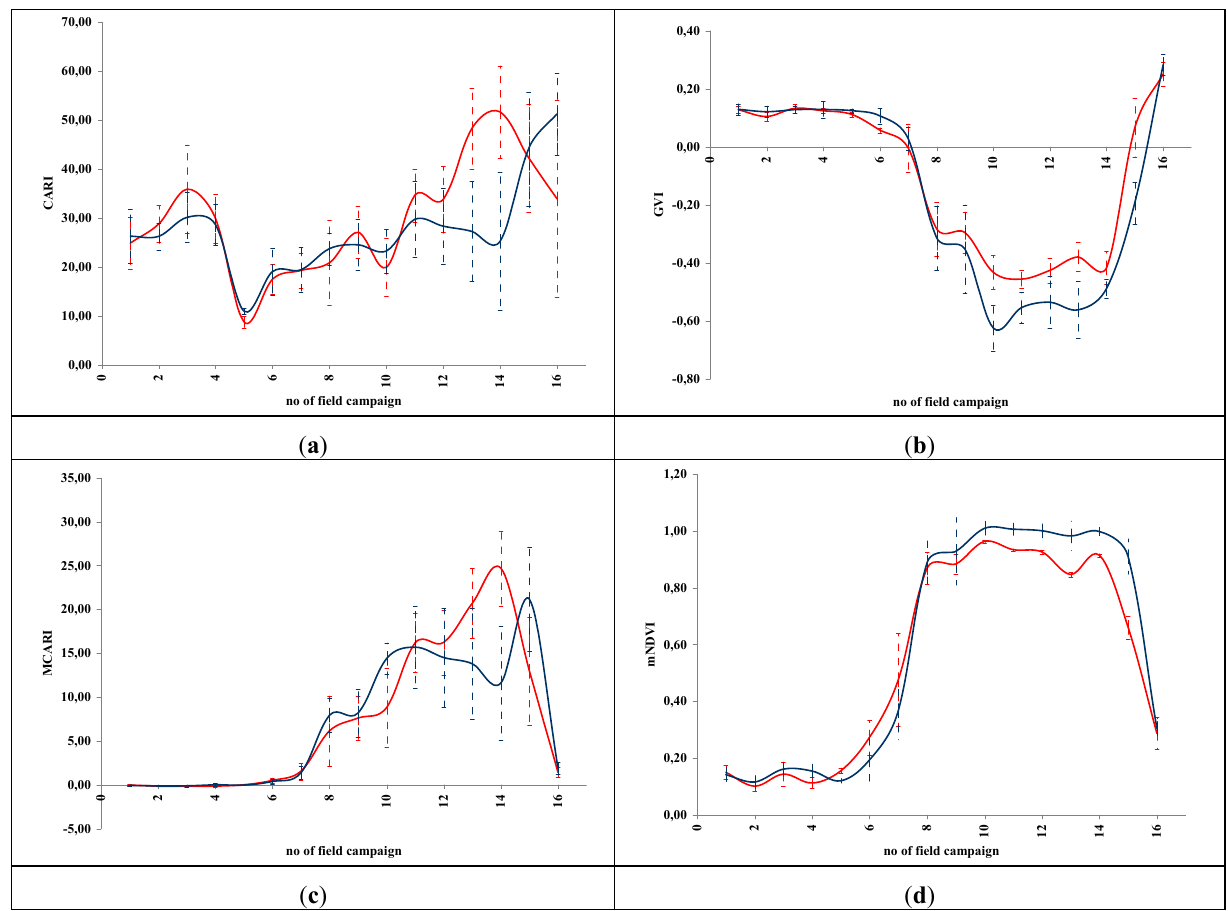
Figure 6. Hyperspectral vegetation indices during the barley crops phenological cycle (2011–2012). Healthy vegetation is indicated with a blue line, while vegetation over archaeological remains is indicated with a red line. ( a ): CARI, ( b ): GVI, ( c ) MCARI, ( d ): mNDVI, ( e ): SR705, ( f ): MSAVI, ( g ): mSR2, ( h ): MTCI, ( i ): mTVI, ( j ): NDVI, ( k ): NDVI2, ( l ): REP, ( m ): SPVI, ( n ): SR, ( o ): SR1, ( p ): TSAVI, ( q ): VOG, ( r ): ARI, ( s ): BRI, ( t ): LIC, ( u ): fWBI and ( v ): WI. No. of field campaign (for dates of measurement, see section 3) is shown in X-axes, while vegetation indices values are shown in Y-axes. Dashed lines are the standard deviation